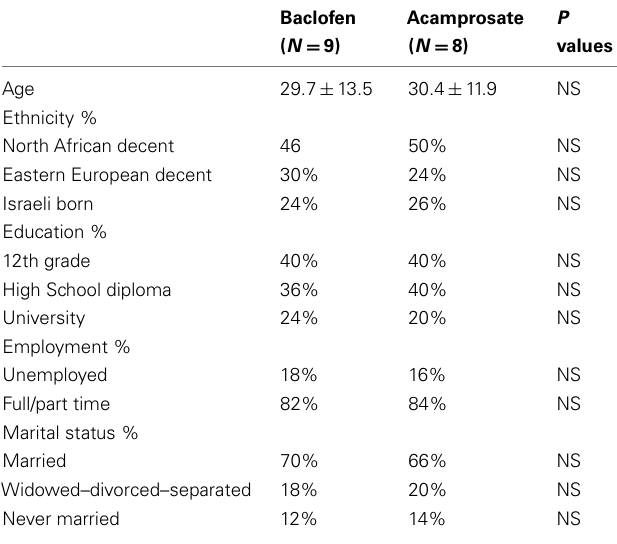
Table 2 | Statistical comparison of HDRS, HARS, andVAS scores of patients treated with acamprosate and baclofen.